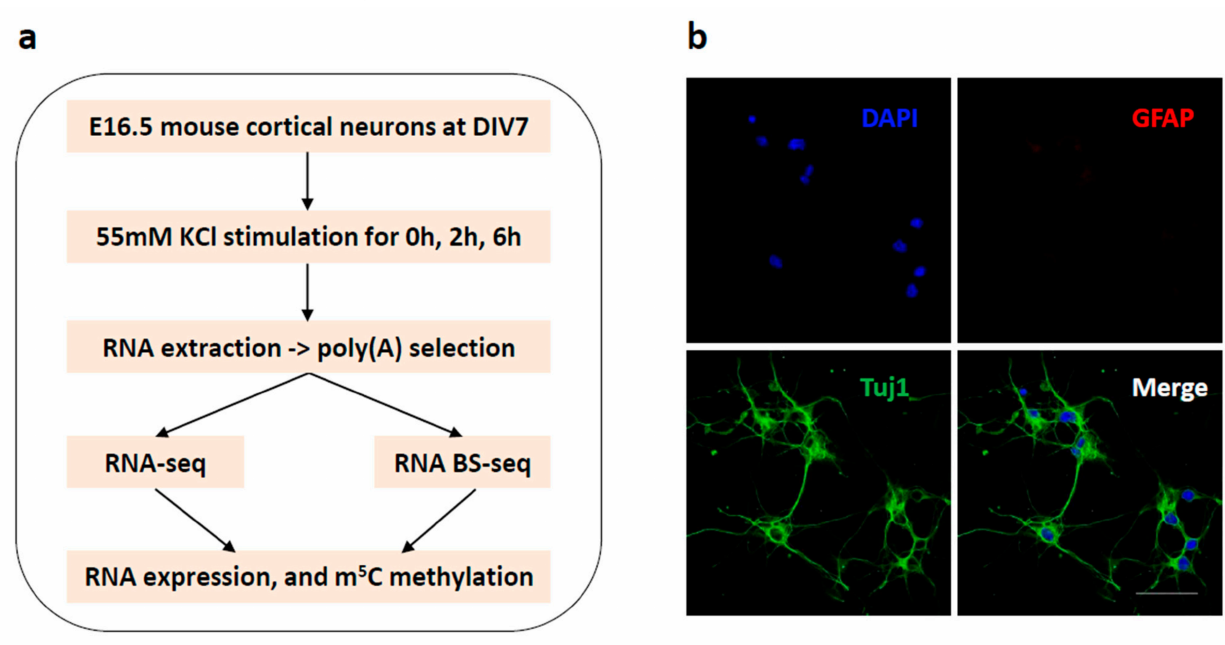
1573 up-regulated genes and 1294 down-regulated genes in the comparison of 2 h vs.